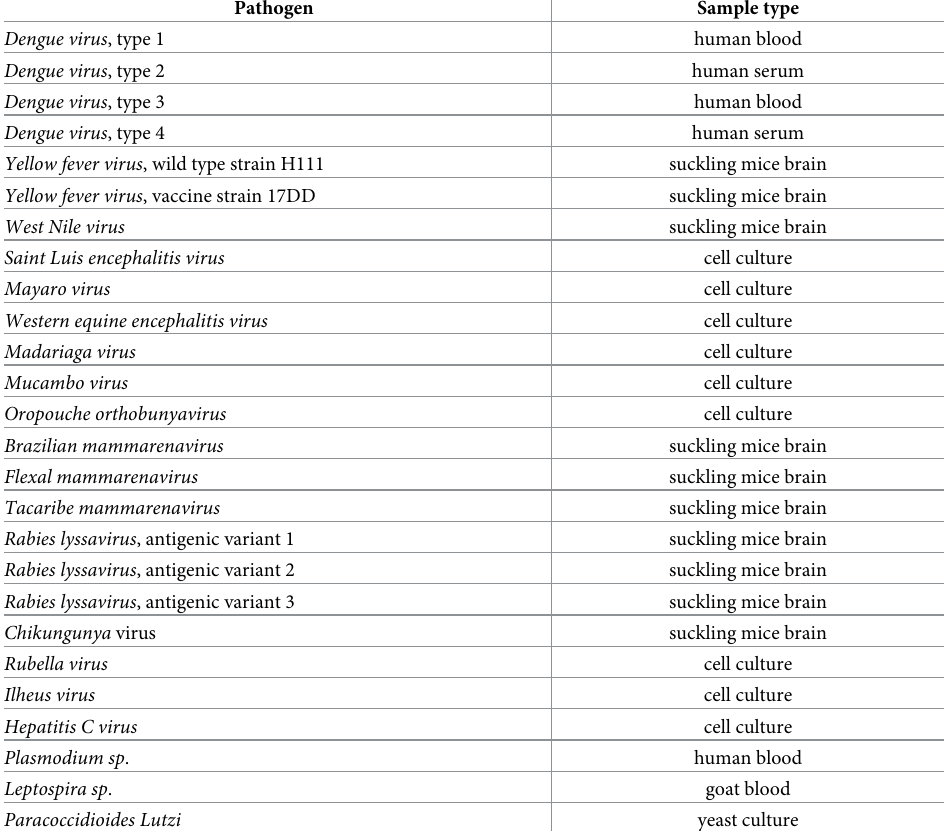
Table 2. Virus and other pathogens tested for